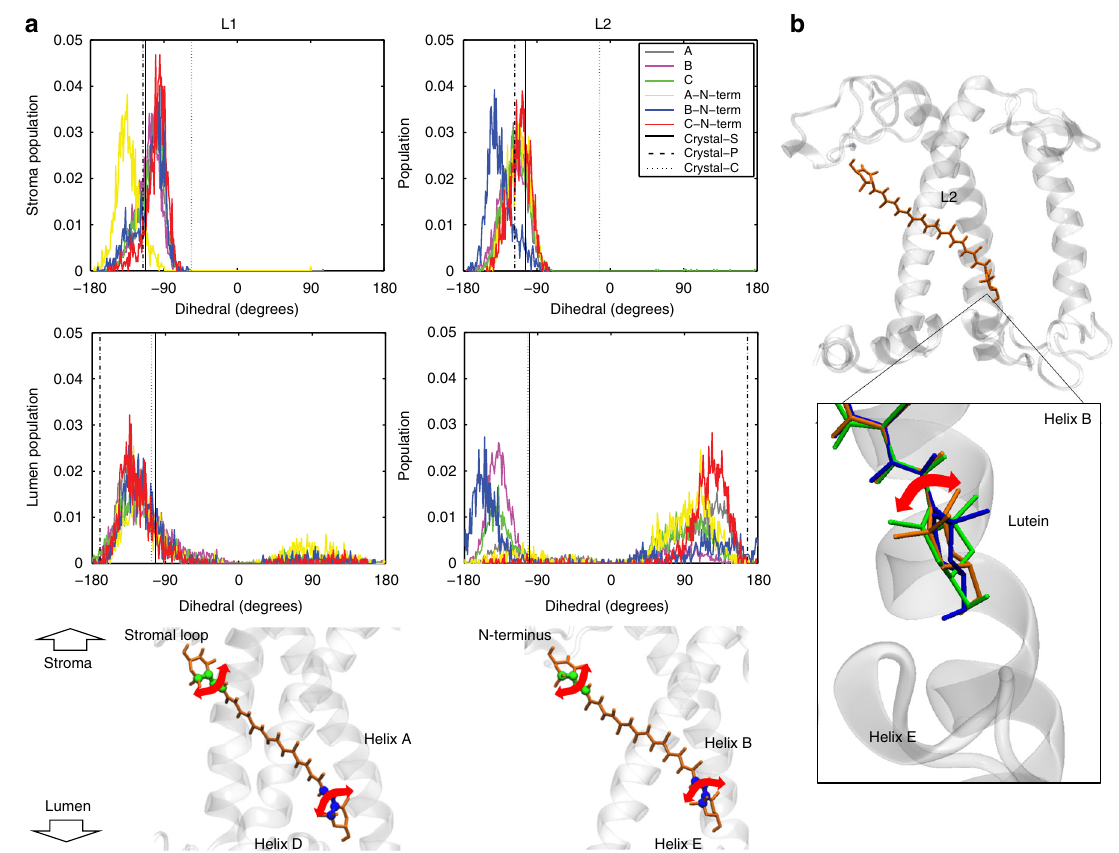
Fig. 5 Conformational fl exibility of the Cars ’ end rings in wild-type LHCII. a The dihedral distributions for the two end rings of lutein bound to site L1 and L2 of LHCII were computed over six independent MD simulations, discarding the fi rst 400 ns of simulation per each run. The different simulations are labeled as in our previous work 7 . The values for the dihedrals measured on three different crystals of LHCII are also reported and are indicated in the plots as Crystal-S, P or C according to the organism from which LHCII was puri fi ed (spinach 27 , pea 45 or cucumber 16 ). The dihedrals of the ring located at the stromal side are reported on the top panels, and those of the ring at the lumenal side are presented in the middle panels. The color scheme for all the plots follows the legend inserted in the plot associated to the L2 site, stromal side (upper right panel of a ). The lower panels show the atoms used to de fi ne this dihedral angle (green for the stromal and blue for the lumenal side of the membrane). Cars are shown as orange sticks. The nearby elements of LHCII apoprotein are shown in transparent white. The left panels are for site L1 and the right for site L2. b A representation of LHCII apoprotein and of the lutein in the L2 site (depicted as in a ) and, in the inset, an example of the rotations of the end-ring of lutein observed at the L2 site in one of the simulations. Different lutein conformations are depicted in different colors and aligned on top of each of singlet-singlet annihilation effects, we also collected data at lower energies (5, 10 to the ones of lutein but for two differences: the presence of two conjugated rings nJ), as described in the caption of Supplementary Table 2. As reported in the same (astaxanthin) instead of one (lutein), and on the presence of two keto groups, each table, the contribution of annihilation to the kinetics is very minor, ranging on one ring (astaxanthin), which are missing in lutein. Parameters and charge used between 1% and 14% for the powers used for these experiments (5 – 15nJ). for the keto groups are the ones already parametrized for the keto groups on the ring of Chls 57 . Parameters compatible to two conjugated rings have been taken into account for astaxanthin. MD simulations . In this work, we present the results of 12 independent classic MD The LHCII wild-type was embedded into a pre-equilibrated 1-palmitoyl-2- oleoyl-sn-glycero-3-phosphocholine (POPC) bilayer via the multi-step protocol simulations of a monomer of LHCII embedded in a model lipid membrane with explicit previously described 7 . In brief, a coarse grained (MARTINI 58 ) system consisting of solvent in the microsecond timescale and with atomistic resolution. All MDs were run LHCII apoprotein, POPC membrane (two homogeneous layers of pure POPC in on the GROMACS simulation package, version 4.6.3 (http://www.GROMACS.org/55). the ratio 204:204 per monolayer) and 5376 MARTINI water beads were minimized Simulations were analyzed using the tools available on the GROMACS platform and on (500 steps of steepest descent) and then relaxed (30 ns, NPT) at 323 K. From the the VMD software (http://www.ks.uiuc.edu/Research/vmd/ 55 ). last step of the trajectories we retrieved the membrane coordinates and converted As in Ref. 7 , all the simulations are based on the crystal structure of a the structure to united-atom resolution (GROMOS 54a7 56 ) via the SUGARPIE monomeric subunit of the LHCII (PDB 1RWT, Chain A) 27 . The monomeric tool 59 . The GROMOS-LHCII pigment – protein complex structure (wild-type) was protein (232 amino acids, residues 14 – 246) has been simulated altogether with its then aligned to the pore present in the GROMOS-POPC bilayer (via editconf tool cofactors: eight chlorophyll a (Chl a), six chlorophyll b (Chl b), and two Luteins of GROMACS 60 , resulting in a fi nal bilayer of 344 POPC molecules) and (Lut 1 and 2), 1 Violaxanthin (Vio), 1 Neoxanthin (Neo), in the case of the wild- consequently solvated the system with water ( > 15k molecules) and ions (neutral type, or three astaxanthin molecules in the case of LHC – Asta. In addition, present physiologic conditions, 10mM Na + Cl − 61 ). are 60 interstitial water molecules (at the start of the simulation) and one DPPG The system was fi rst minimized (steepest descent) and relaxed (10ps, (1,2-dipalmitoyl-sn-glycero-3-phosphoglycerol) lipid molecule. The simulations NVT + 40ns NPT). During all these steps, isotropic strong position restraints here described for the LHCII wild-type monomer are the same as in ref. 7 , whereas were applied to the protein (backbone) and to all its ligands (Chl – tetrapyrroles the ones of LHC – Asta represent a new set of simulations. and whole Cars and DPPG molecule structures) to avoid perturbation of the The force fi eld used for all the simulations is a united-atom force fi eld protein and cofactors crystal positions. Position restraints were set to a starting (GROMOS 54a7 56 ), where all the titratable amino acids were considered to be in value of 10,000 kJmol − 1 nm − 2 and then gradually reduced to zero every 10ns the standard protonation state at pH 7. The force – fi eld parameters for the Chls, of NPT simulation (for a total of 40 ns simulated time), following the sequence Cars, and DPPG have been derived compatibly with the GROMOS 53a6 force fi eld, 1000 → 1000 → 500 → 200 kJmol − 1 nm − 2 . as previously reported 7,57 . The force – fi eld parameters for astaxanthin are identical